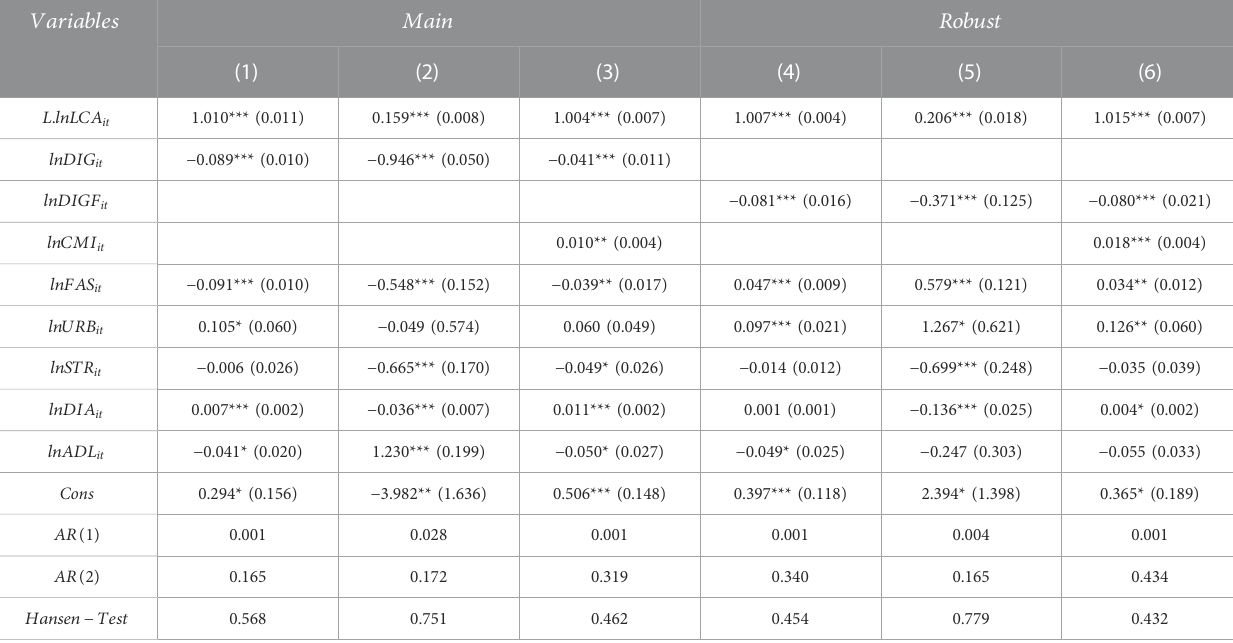
TABLE 7 The results of the mediating effect of agricultural capital misallocation. Variables